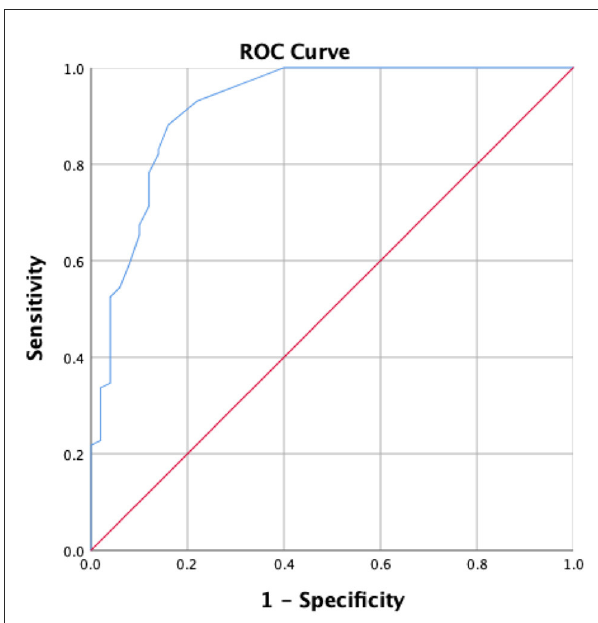
FIGURE3 Receiver operator characteristics of the C-UEFI to distinguish stroke subjects ( N 101) from healthy subjects ( N =